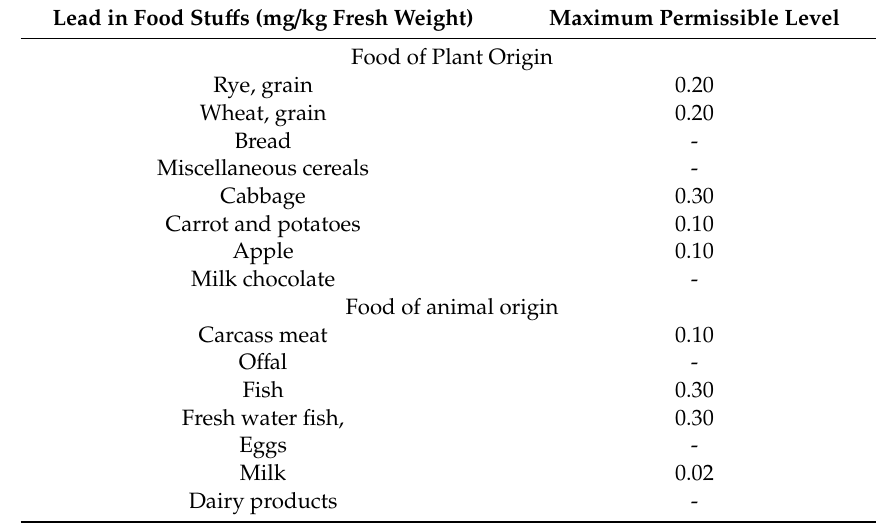
Table 5. Maximum permissible level of Pb in foodstu ff s (mg / kg Fresh